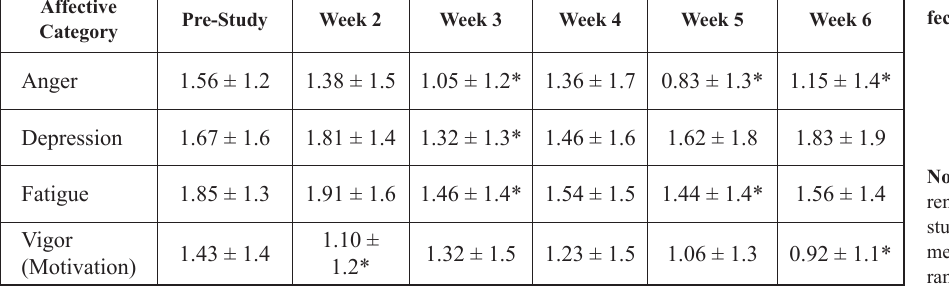
Table 5. REST-Q score by af